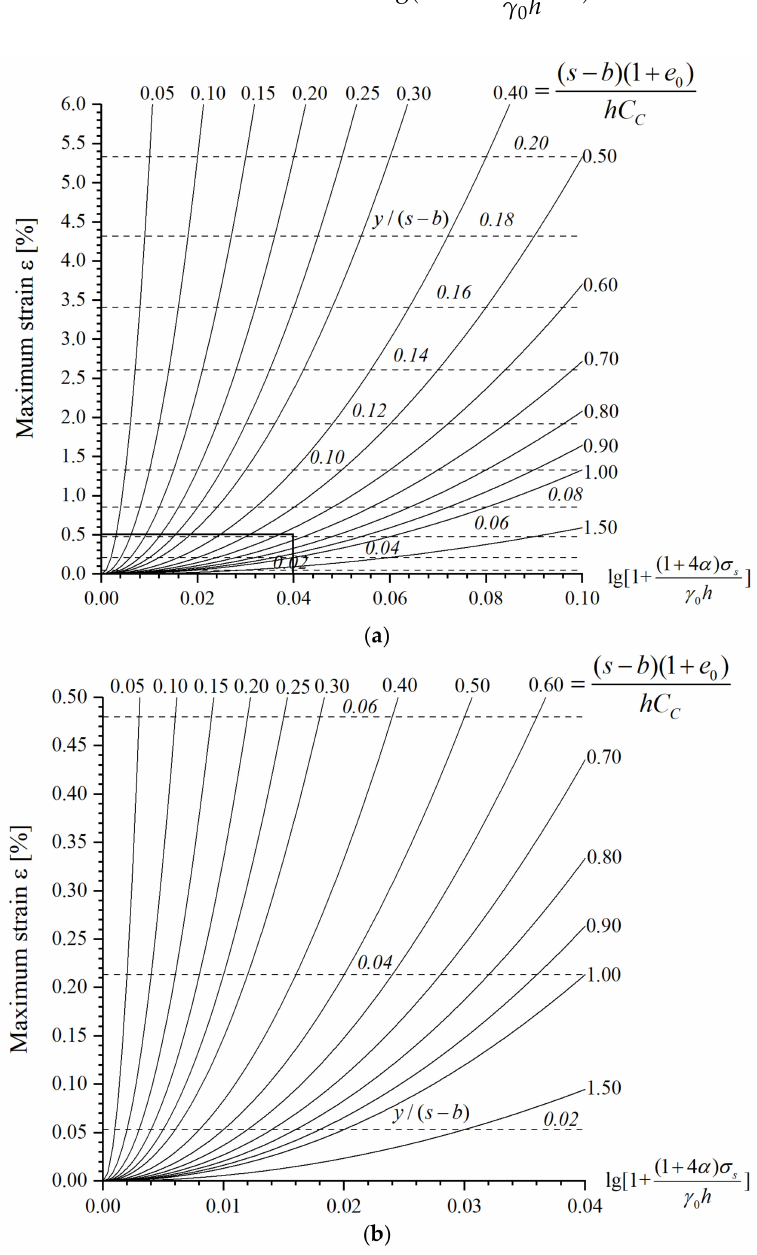
Figure 5. Design charts for a GRPE with a normally consolidated subsoil; ( a ) Full-scale chart; ( b ) Enlarged